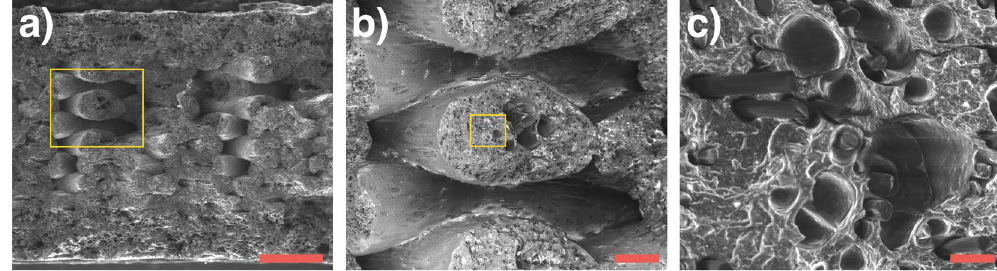
Figure 4. SEM micrographs of the fracture surface of FDMed SCFR-ABS with a 100% infill including ( a ) inter- bead porosity, ( b ) inherited porosity, and ( c ) inner-bead porosity. Micrograph ( b ) shows the magnified yellow rectangle in ( a ) and ( c ) shows the magnified yellow rectangle in ( b ). Scale bars represent ( a ) 1 mm, ( b ) 200 μ m, and ( c ) 20 μ